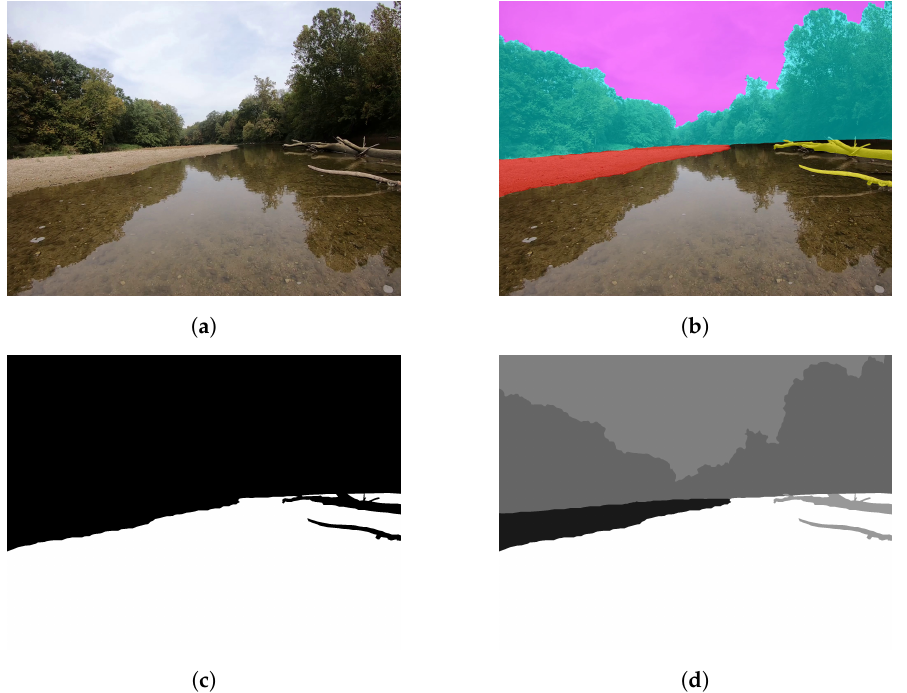
Figure 2. ( a ) An example of one of the 549 dataset images ( b ) Multi-Class Mask overlaid onto the image, ( c ) Binary classification mask for navigational purposes showing non-water and water segmented regions, ( d ) Multi-class segmentation mask